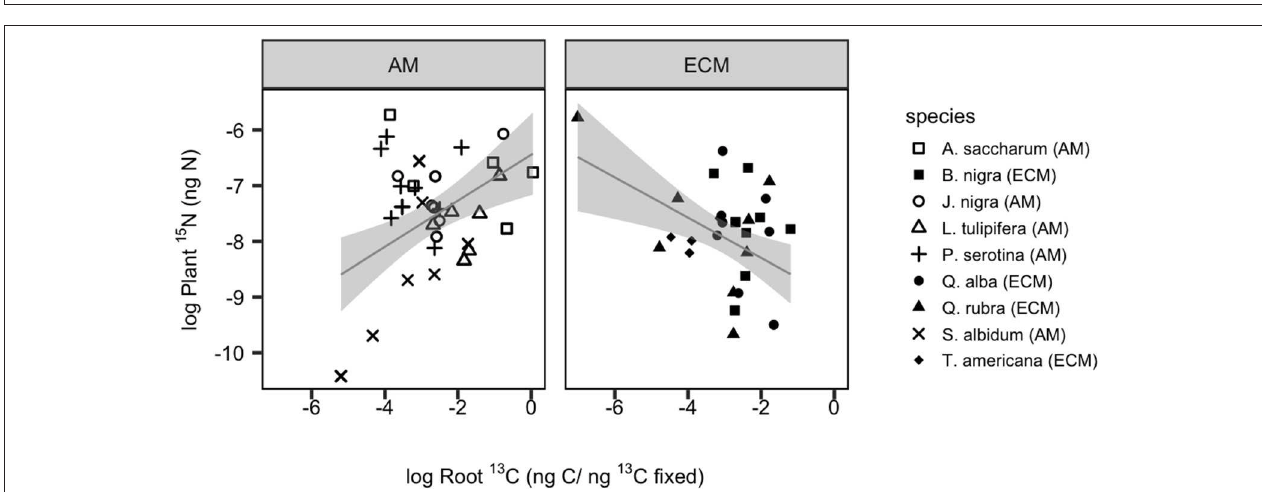
FIGURE 3 | Variation in belowground allocation of recently-fixed C (as measured by absorptive root 13 C enrichment) in relation to plant N uptake (as measured by whole plant 15 N enrichment). Individual species are shown with unique symbols, with filled shaped representing ECM species. Linear regression lines of best fit for each mycorrhizal type are shown with 95% confidence interval individually. For AM species, r 2 = 0.18, P = 0.001; for ECM species, r 2 = 0.19, P = 0.003.